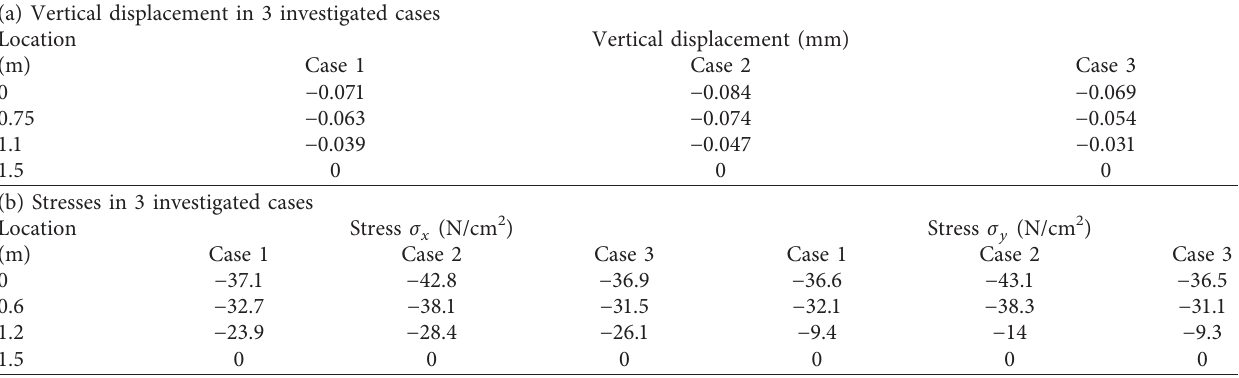
Figure 14: Vertical displacement and stresses in 3 investigated cases: (a) vertical displacement of shell in 3 investigated cases; (b) stress σ shell in 3 investigated cases; (c) stress σ y of shell in 3 investigated cases. Table 4: Vertical displacement and stresses values.